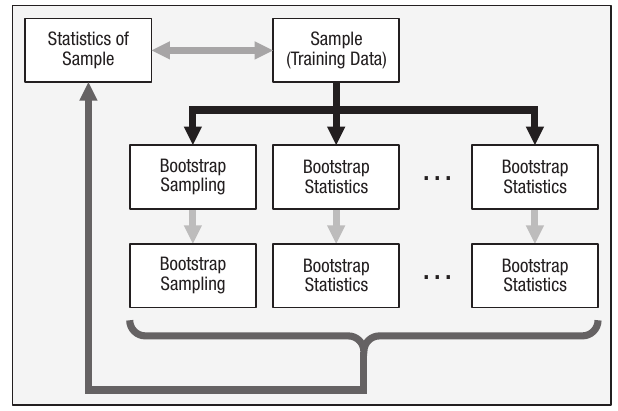
Fig. 1 . Bootstrap